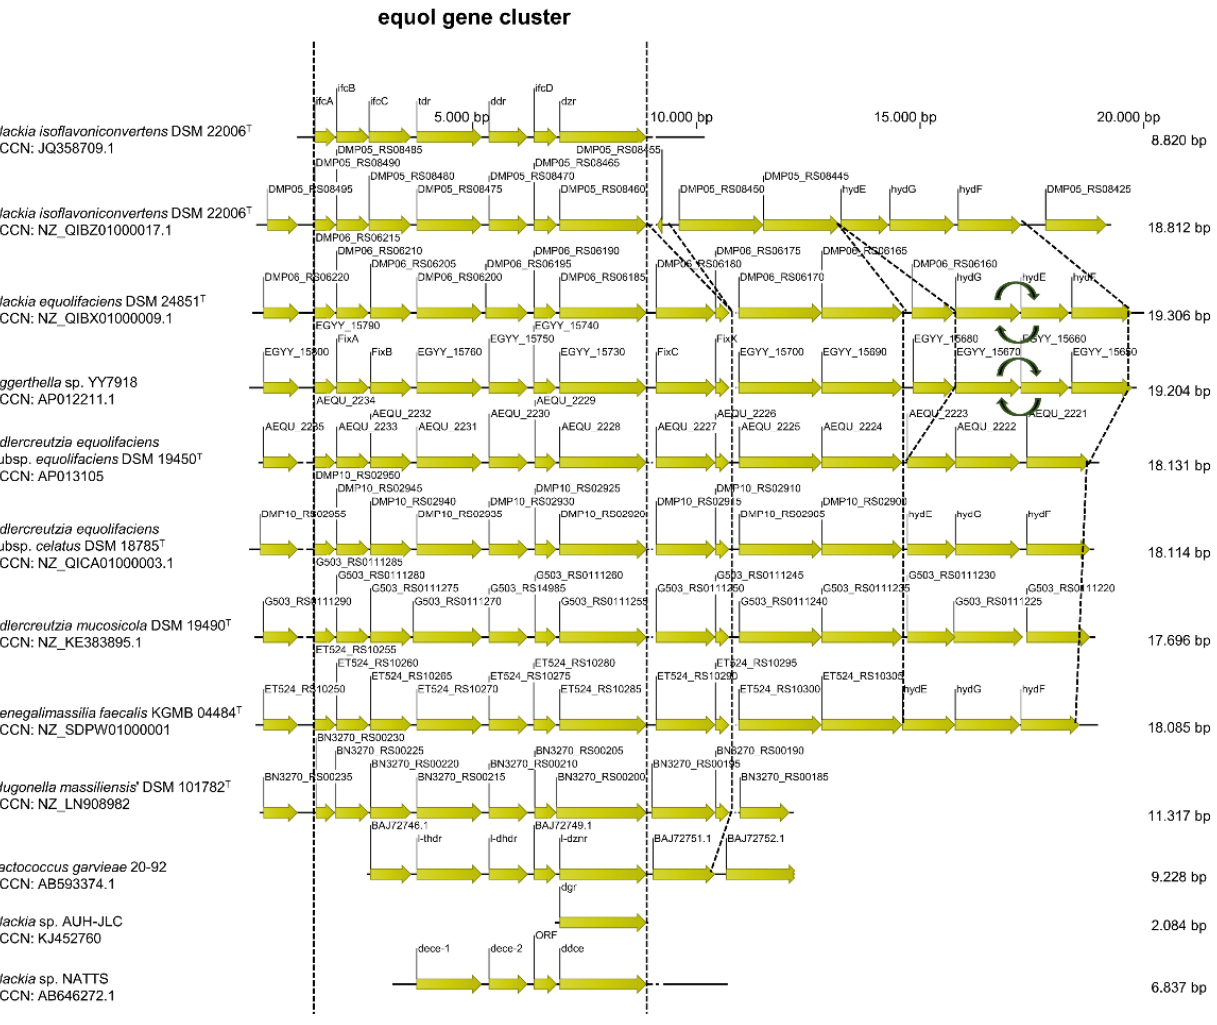
Figure 3. Schematic representation of the gene organization within the equol gene cluster (dihydrodaidzein racemase (DDRC), tetrahydrodaidzein reductase (THDR), dihydrodaidzein reductase (DHDR), and daidzein reductase (DZNR)) as well partial downstream and upstream genes based on amino acid sequences. The respective accession numbers were obtained from the National Center for Biotechnology Information (NCBI, https://www.ncbi.nlm.nih.gov/, (accessed on 14 August 2019)) and aligned using clustalW algorithm in the CLC Sequence Viewer software (version 8, Qiagen).